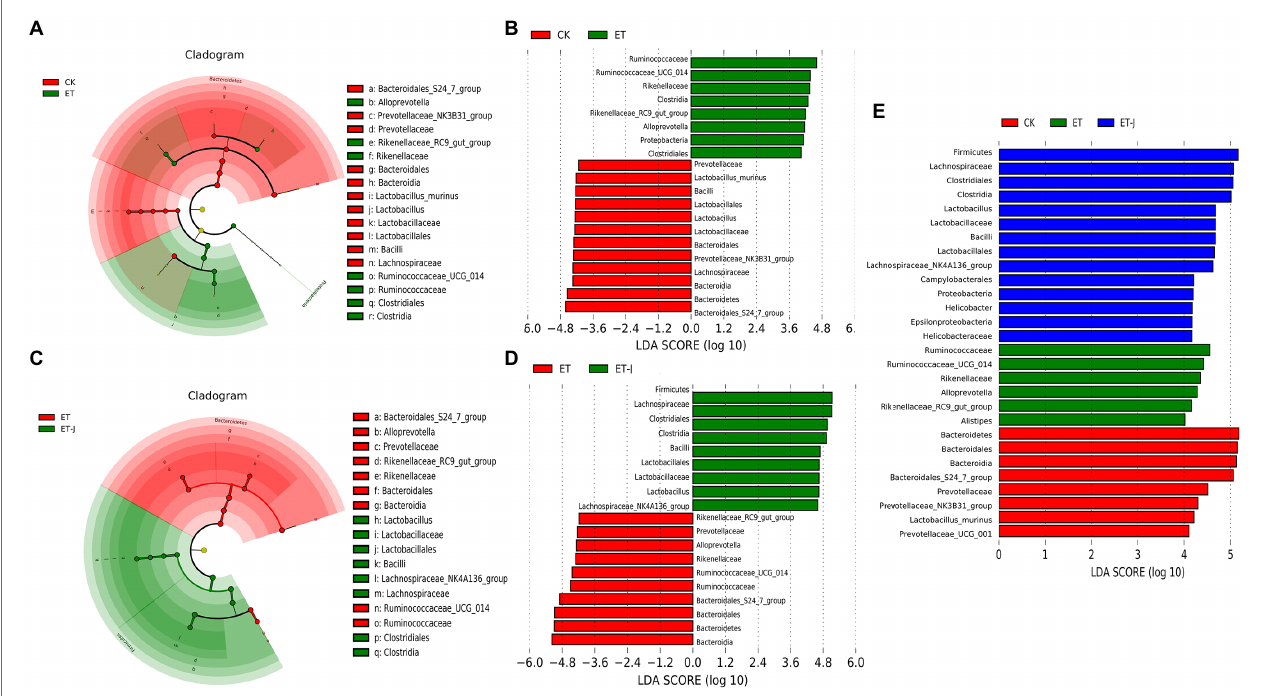
FIGURE 6 | The fermentation broth reshaped the gut microbiota community. (A) LEfSe cladogram represents the taxa enriched in the CK group (red) and ET group (green). (B) Discriminative biomarkers with an LDA score > 4 between the CK group (red) and ET group (green). (C) LEfSe cladogram represents taxa enriched in the ET group and ET-J group. (D) Discriminative biomarkers with an LDA score > 4 between the ET group (red) and ET-J group (green). (E) Discriminative biomarkers with an LDA score > 4 between the ET group (red) and ET-J group